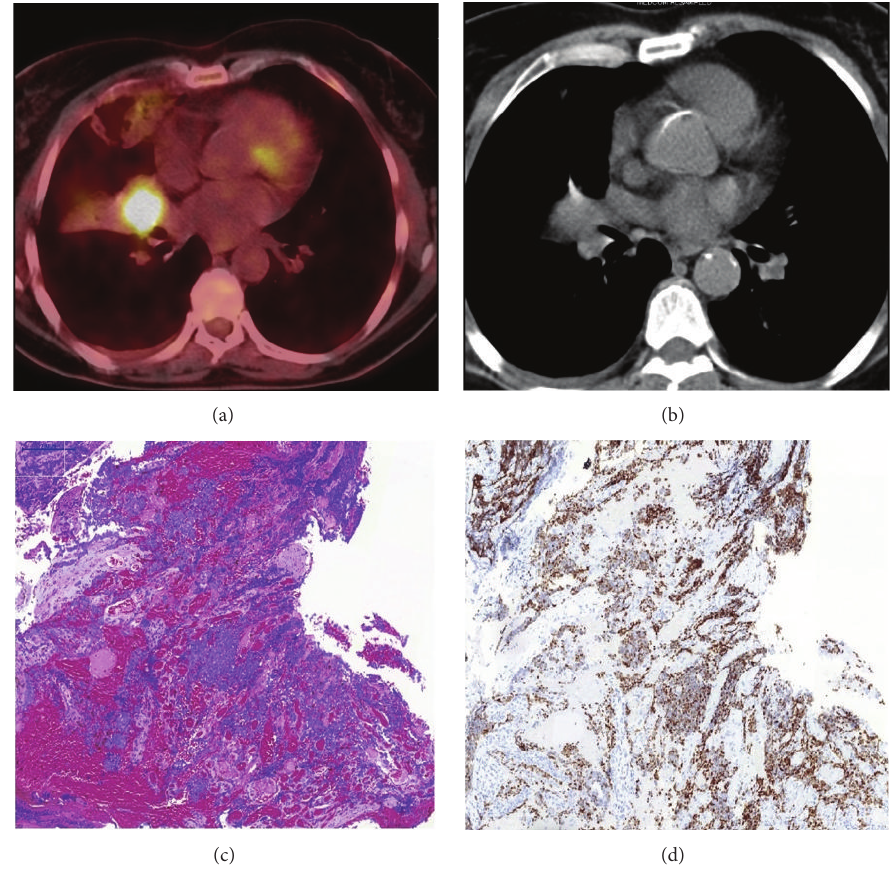
Figure 1: ((a) and (b)) A hypermetabolic primary mass distal to the bronchus of the right middle lobe on PET-CT. (c) Infiltration of small cell carcinoma in transbronchial biopsy of the mass (H&E, × 10). (d) Thyroid transcription factor-1 (TTF-1) positive staining of tumor cells (TTF-1, ×